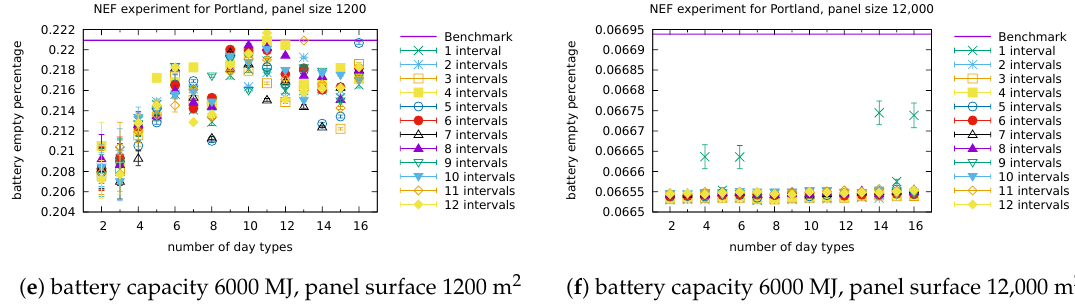
Figure A1. Empty ratio, Portland: Detailed performance of our model for several settings of the battery capacity and panel surface with Google consumer ( a , b ) and NEF consumer ( c – f ).